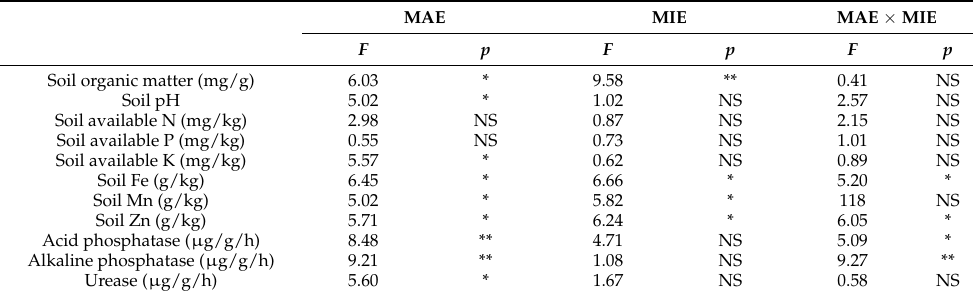
Table 2. Two-way ANOVA of the effect of MAE and MIE on soil physicochemical parameters of Chinese yam.